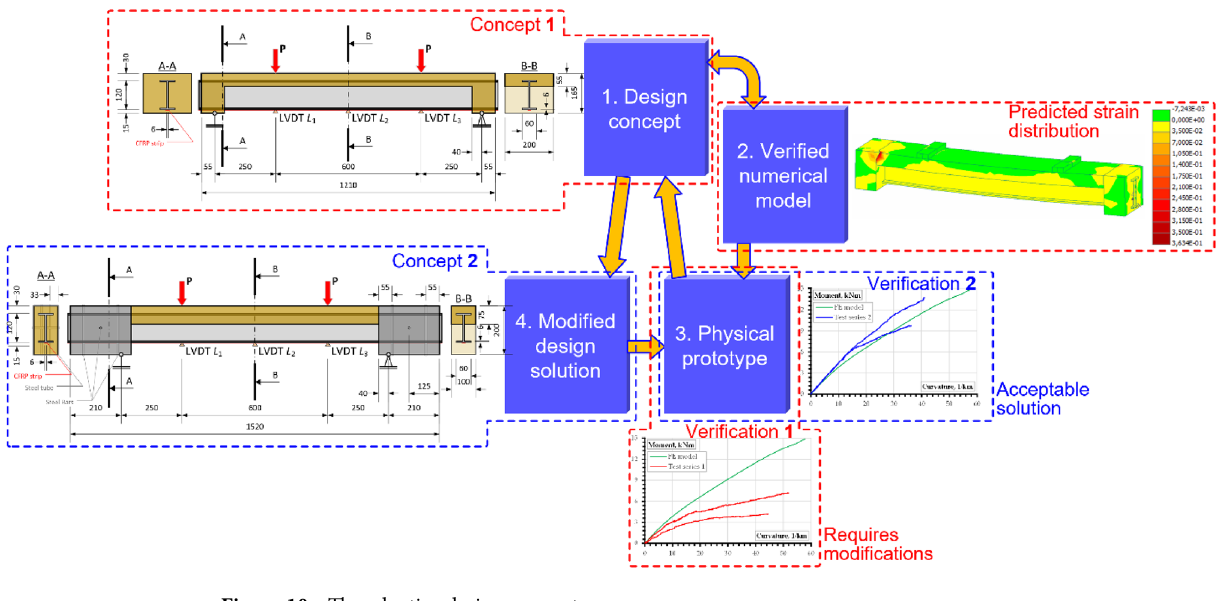
Figure 10. The adaptive design